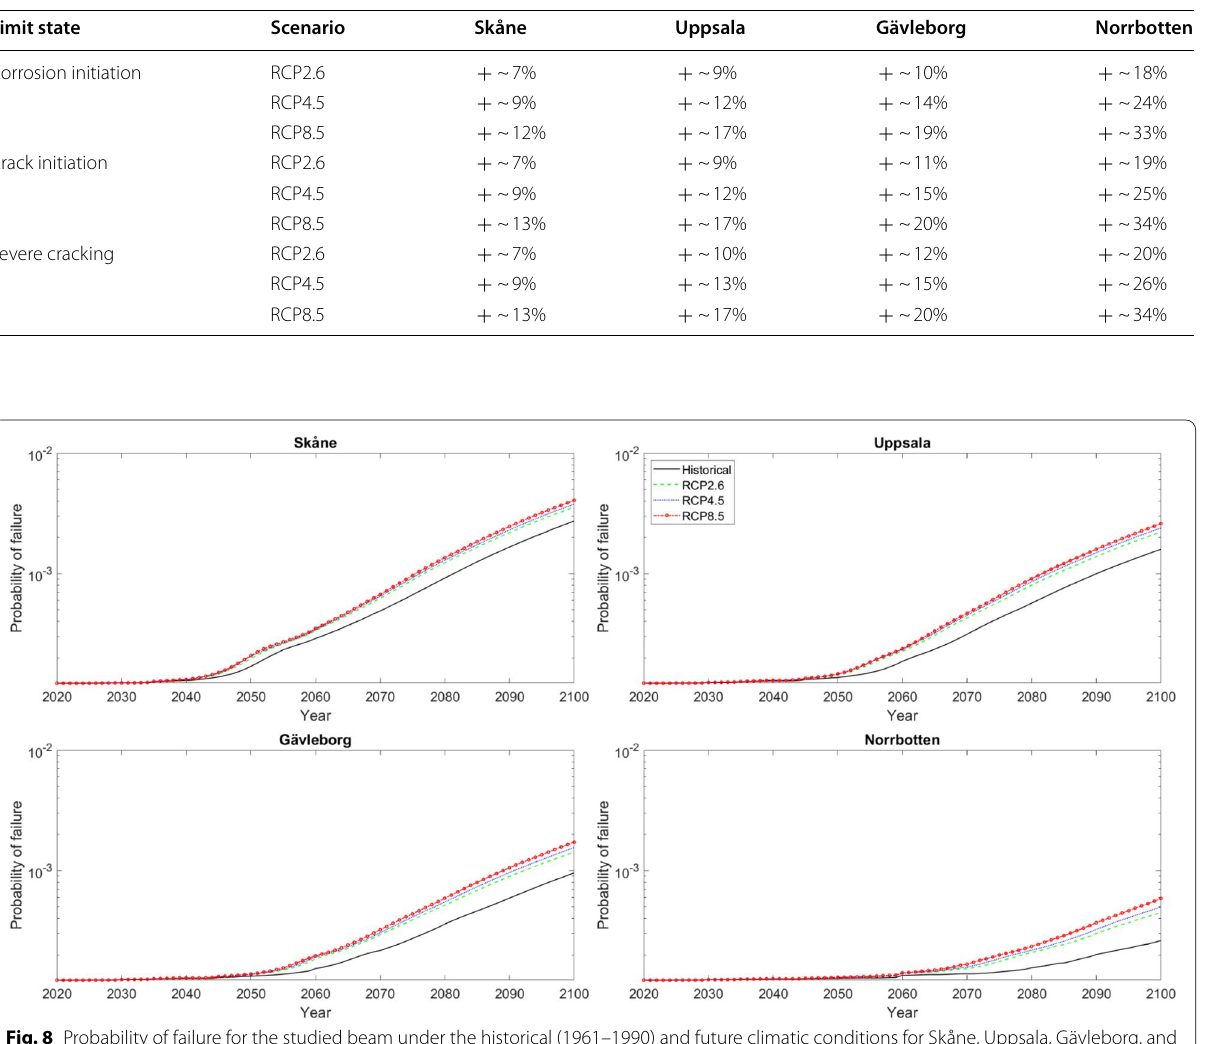
Table 2 Trends in the end-of-century percentage increases in the probabilities of corrosion initiation, crack initiation, and severe cracking due to climate change for Skåne, Uppsala, Gävleborg, and Norrbotten